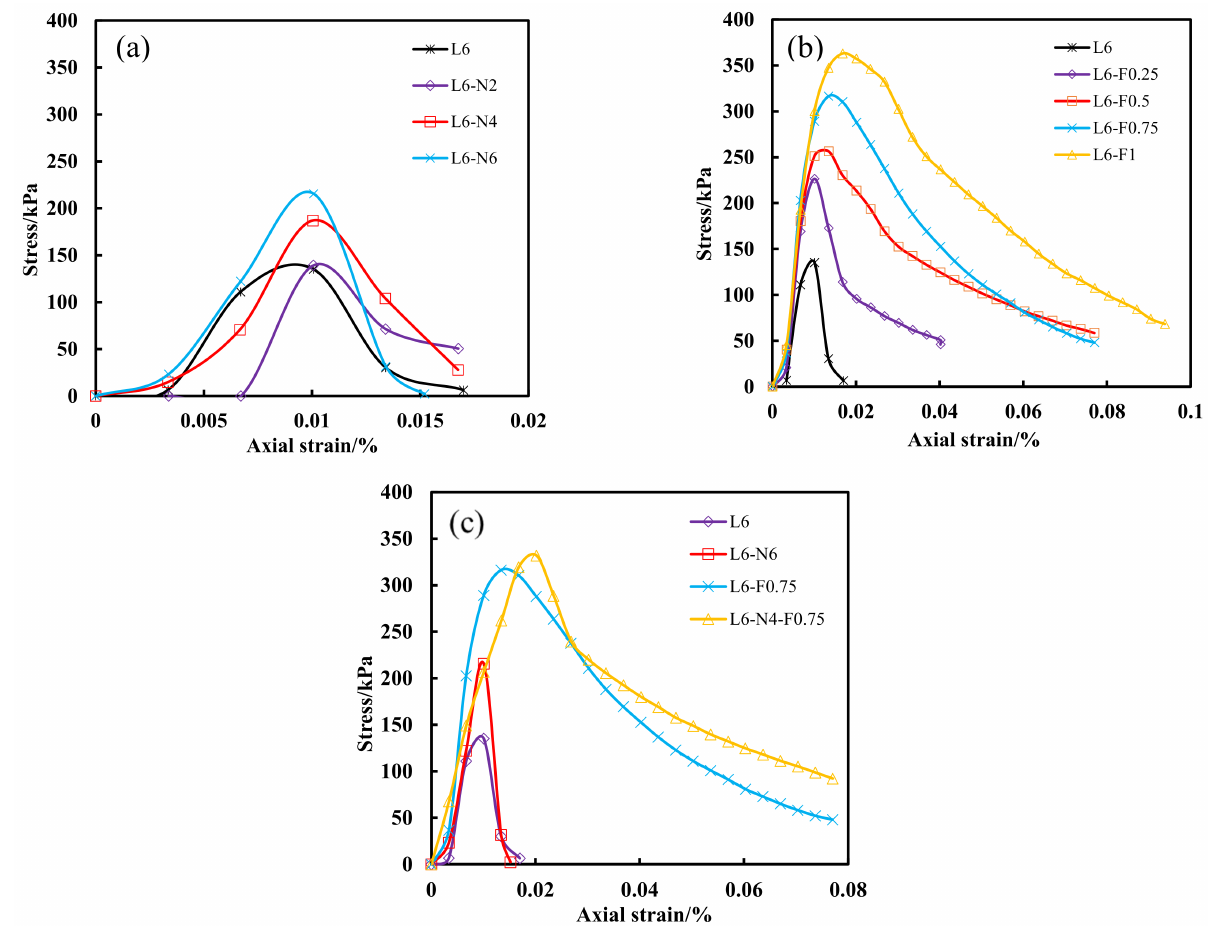
Figure 7. Stress-strain curves of STS tests. ( a ) NLS with different nano clay content; ( b ) FLS with different fiber content; ( c ) NFLS with different nano clay content and fiber content.